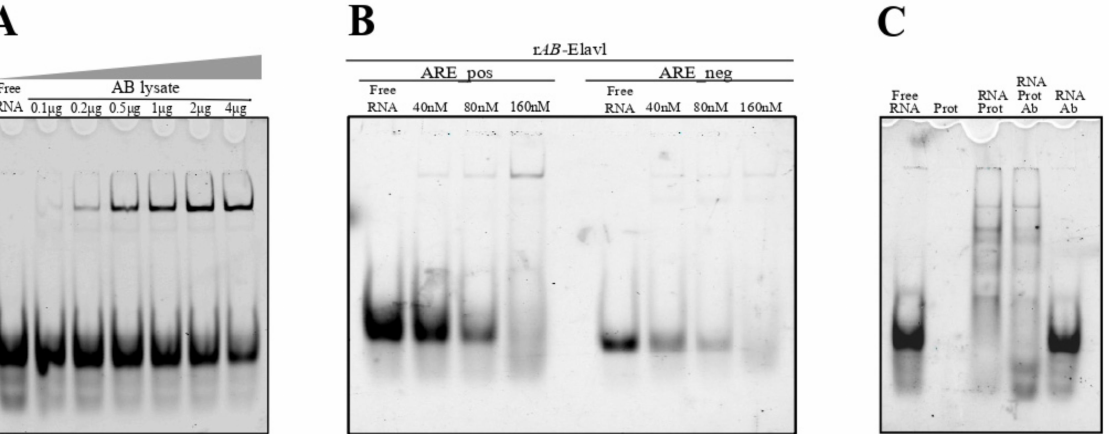
Figure 6. Analysis of the protein binding abilities. ( A ) REMSA assay on the total protein lysate of A. baumannii and a probe mimicking the AU rich sequence of TNF α (ARE pos) with an infrared tag. ( B ) REMSA assay on the recombinant protein incubated with different probes with an infrared tag: ARE pos and ARE neg. ARE pos is bound with a high affinity, while ARE neg shows a lower affinity. ( C ) REMSA assay for detection of the super-shift in presence of the antibody against AB -Elavl. The super-shift is not